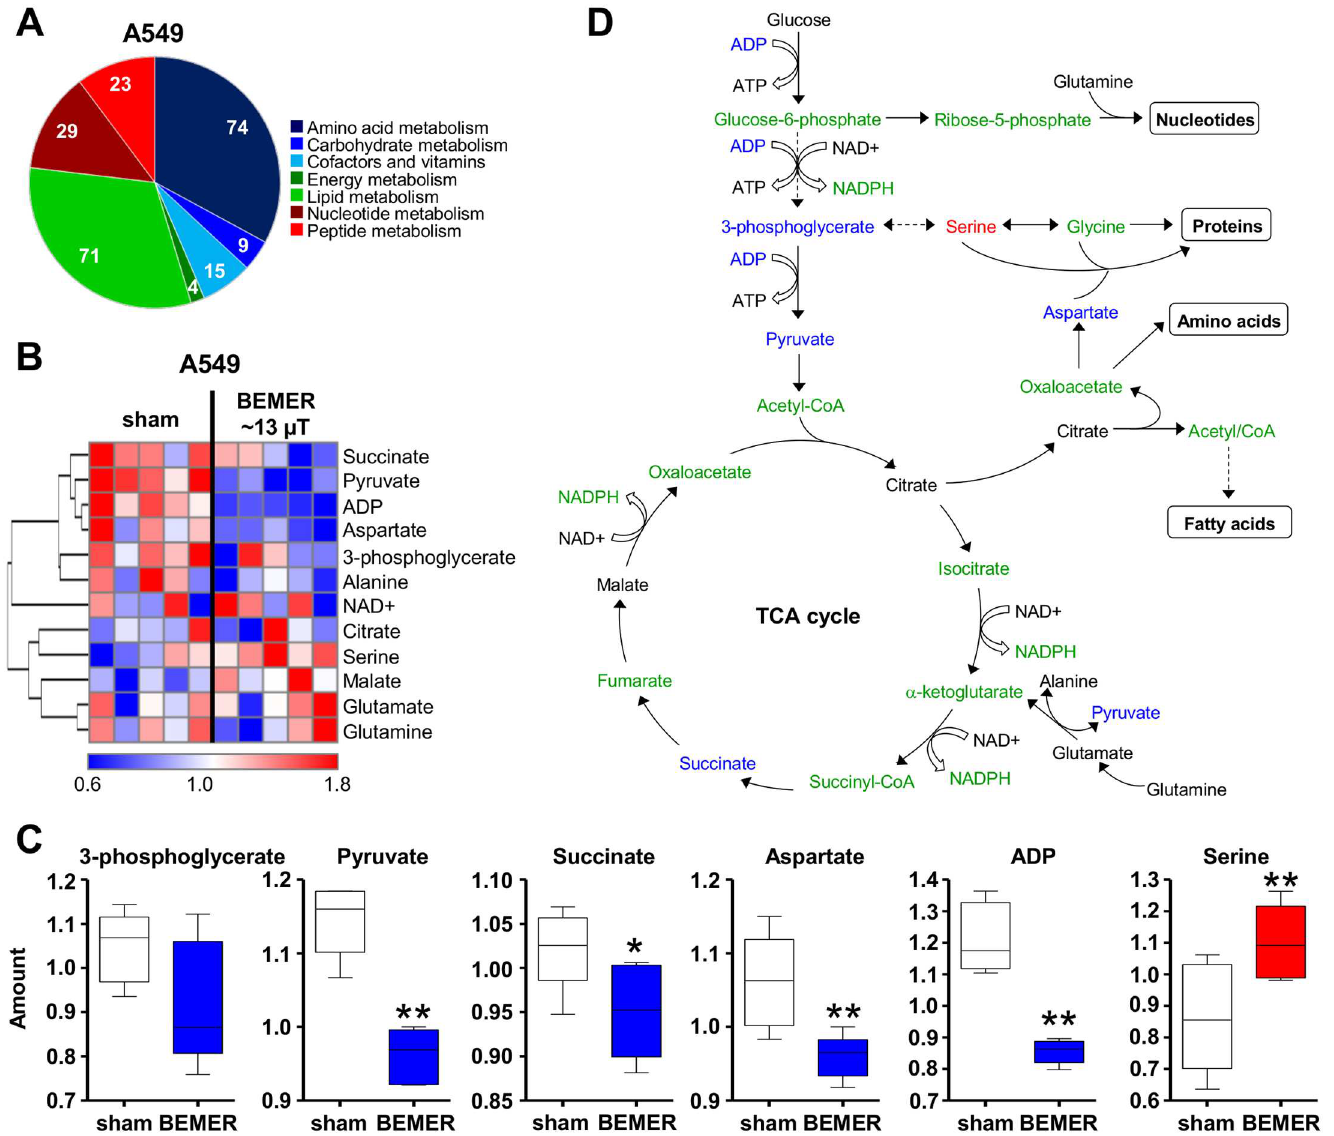
Fig 2. The specific BEMER EMF pattern impacts on cancer cell metabolism. (A) Pie chart showingthe numberof detected metabolites categorized by pathways ( Σ 225). (B) Heatmap comparing levels of metabolites in BEMER signal treated (~13 μ T, 8 min) and BEMER sham-treated (sham) A549 cells. Red and blue indicate up- and downregulation, respectively. Cells were culturedin 3D lrECM for 24 h prior to BEMER treatment. (C) Amount of indicatedmetabolites in A549 cells without (sham) and with BEMER EMF exposure. (D) Scheme of glycolysis and TCA cycle. Metabolites in blue were downregulated, in red upregulatedand in black unaffectedupon BEMER therapy compared with sham-treated controls. Metabolites depictedin green were not measuredin the metabolome analysis. All results represent mean ± SD. Student’st-test. n = 5. * P < 0.05; ** P < 0.01.